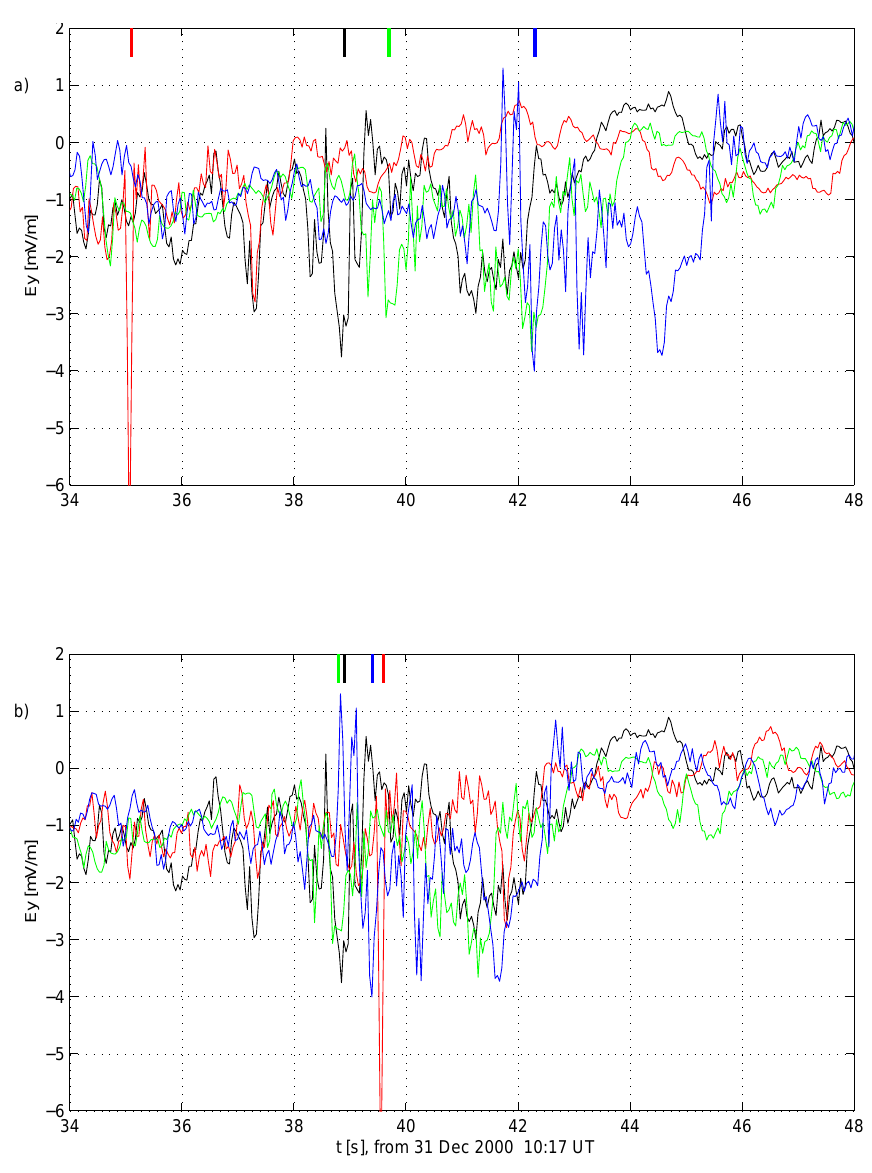
Fig. 7. (a) The E y component of the electric field from 10:17:00 UT on 31 Decemeber 2000, for all four Cluster satellites (1:black; 2:red; 3: green; 4:blue), (b) The same signals, but shifted in time to correspond to a common moving magnetopause frame.